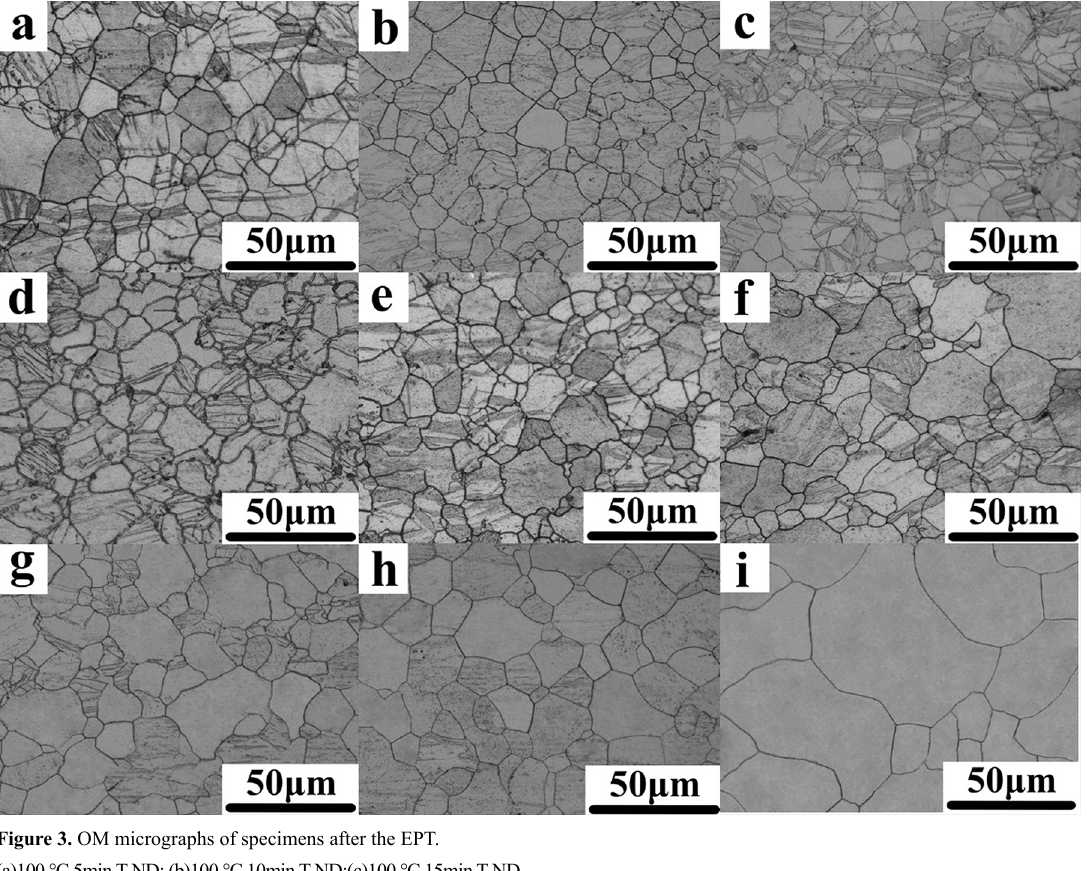
Figure 3. OM micrographs of specimens after the EPT.